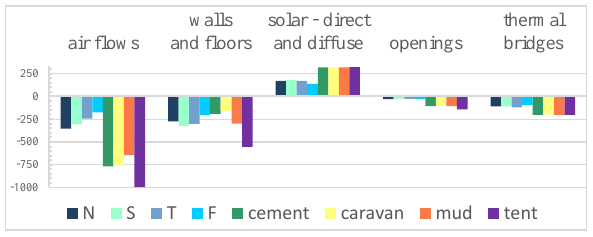
Figure 13. Heat balance for one year, W.